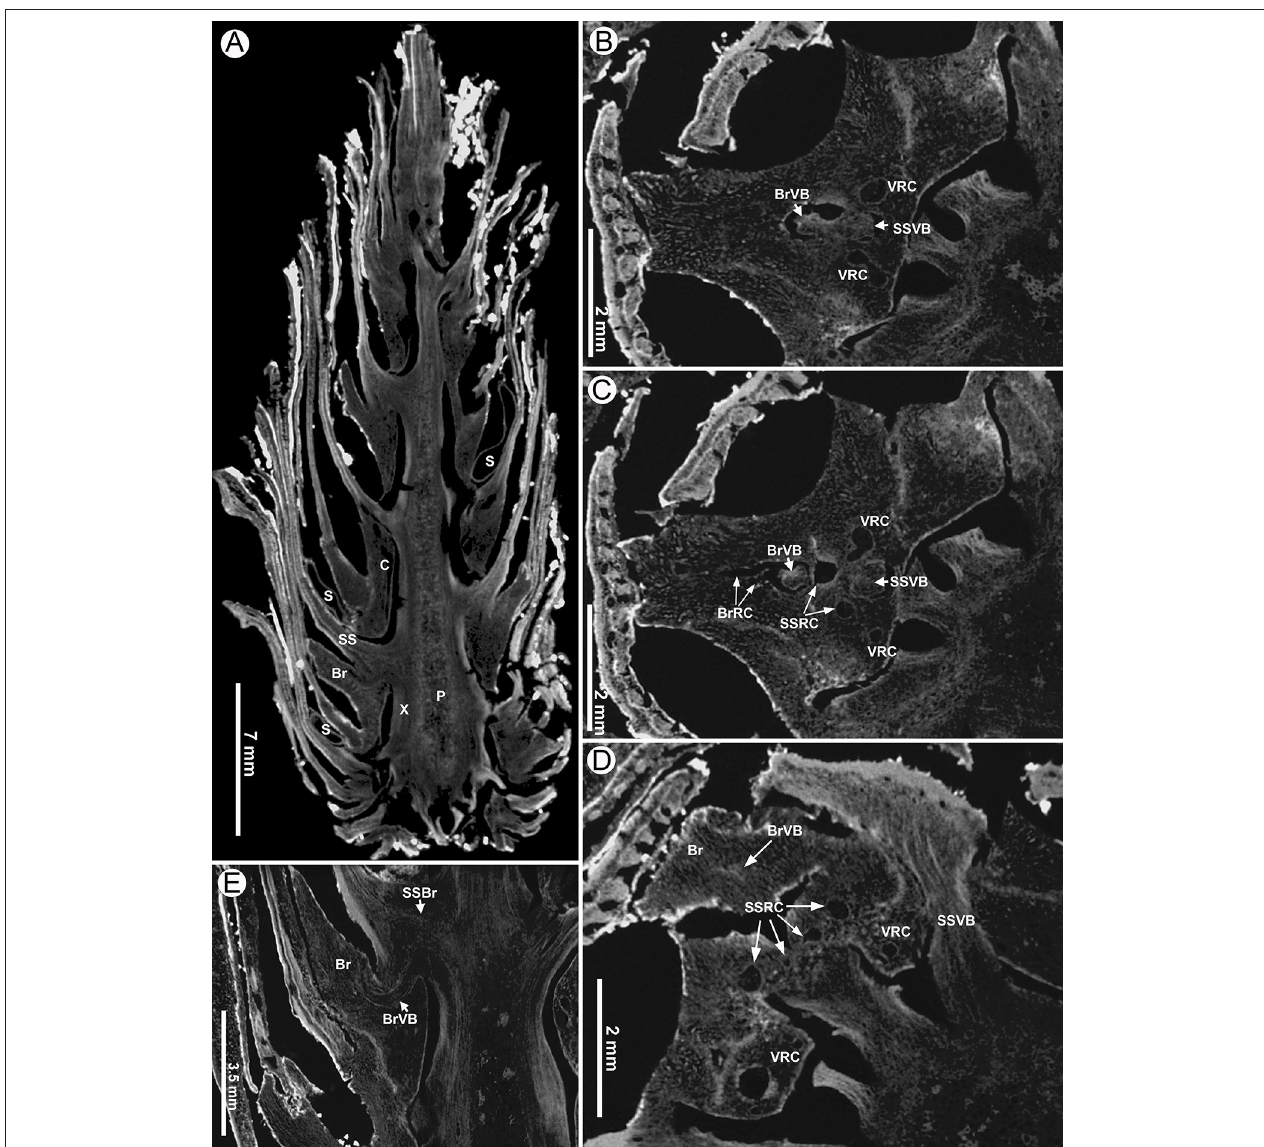
FIGURE 10 | Virtual sections of a seed cone of Pinus prehwangshanensis sp. nov., holotype, specimen MMRH170, micro-CT. (A) Longitudinal section of a seed cone showing a cone axis (P – pith, X –xylem, C – cortex) and numerous bract-scale complexes (SS –seed scale, Br – bract) bearing seeds (S). (B,C) Two lateral resin canals (VRC) giving rise to resin canals of a seed scale (SSRC) and bract (BrRC); note the vascular bundles of a seed scale (SSVB) and bract (BrVB) (enlargements in Figures 8E,F , respectively). (D) A bract (Br) separated from a seed scale by a medial pouch, a vascular bundle of a bract (BrVB) is visible; note a vascular bundle of a seed scale near its base (SSVB), resin canals of a seed scale (SSRC), and two vertical resin canals (VCR) (an enlargement in Figure 8D ). (E) Longitudinal section of a seed cone showing a bract (Br) and vascular bundles of a bract (BrVB) and a seed scale (SSVB).